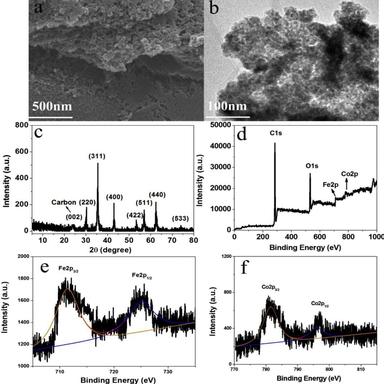
SEM image (a), TEM image (b), XRD pattern (c) and XPS spectra (d, e, f) of CDC/CoFe2O4 (3) composites.